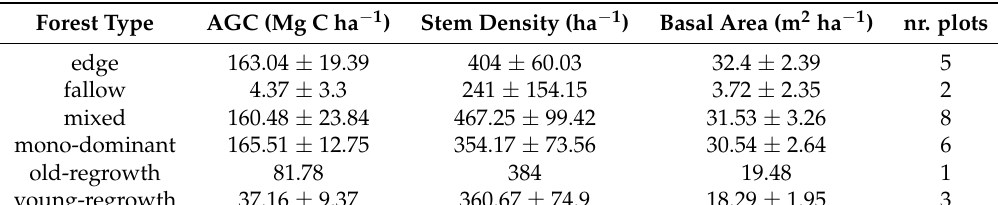
Table A3. Summary statistics for different forest plot types. We report the mean and standard deviation for Above Ground Carbon (AGC), basal area, stem density values and number of plots (as mentioned in Appendix A Table A1).